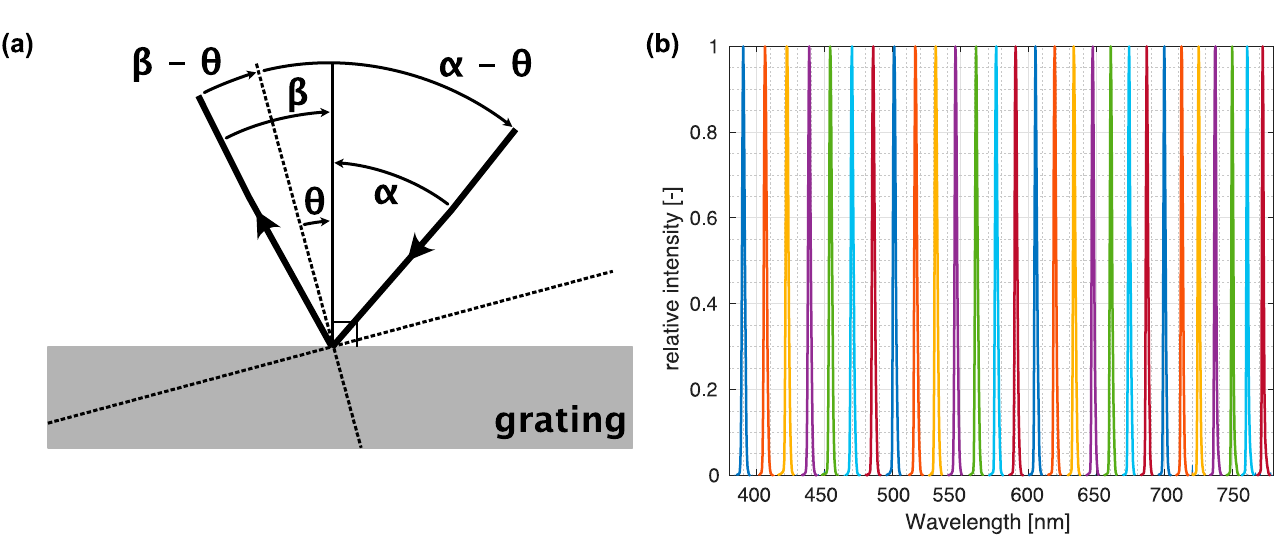
Figure 3. Monochromator angles and spectra. ( a ) Schematic of angles in monochromator equations. Arrows indicate the direction of positive angles. ( b ) Spectra acquired with the spectrometer (normalized to 1).